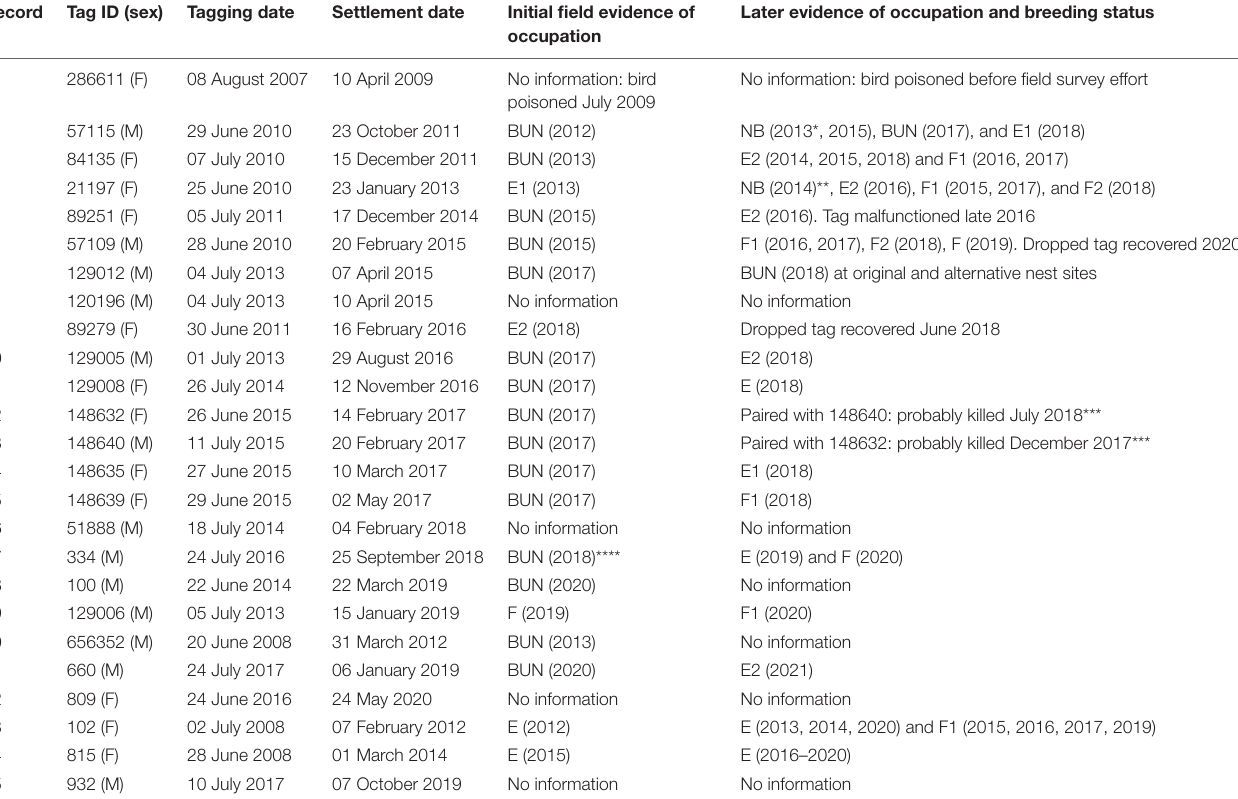
TABLE 1 | The 25 satellite tagged birds deemed to have settled on a prospective breeding territory with a summary of subsequent field records at respective putative territories. Record Tag ID (sex) Tagging